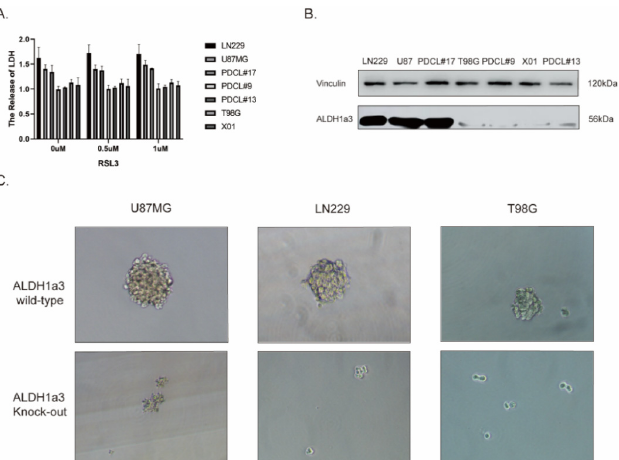
Figure 2. The sensitivity to RSL3-induced ferroptotic cell death in glioblastoma correlates with expres- sion of ALDH1a3. ( A ) Relative LDH release (1.0 = untreated controls) after RSL3 treatment confirmed the cell viability results. RSL3 induced cell death in LN229, U87MG, and PDCL#17 cells, but not in T98G, PDCL#9, PDCL#13, and X01 cell lines. ( B ) Expression of ALDH1a3 protein was assessed in seven cell lines by Western blot analysis. RSL-3-sensitive LN229, U87MG, and PDCL#17 cells showed strong expression of ALDH1a3, whereas RSL3-resistant T98G, PDCL#9, PDCL#13, and X01 cells showed only weak expression. Vinculin served as a loading control. ( C ) ALDH1a3 high-expression U87MG and LN229 cells, and ALDH1a3 low-expression T98G cells, respectively, and their corre- sponding ALDH1a3 knockout cells were seeded into ultralow-attachment plates and were grown under primary cell culture conditions for 7 days. All three cell lines showed sphere formation with much smaller spheres in T98G cells under primary cell culture conditions. Sphere formation was completely abolished in knockout